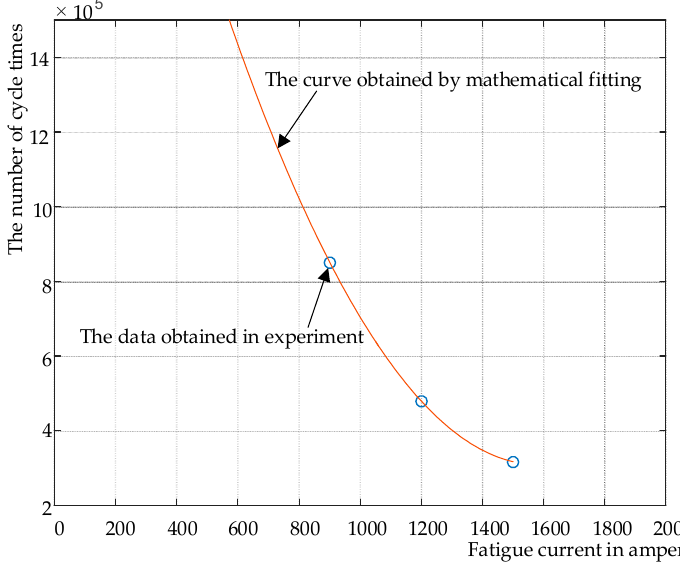
Figure 16. Experimental results of BAFT and fitting curves.